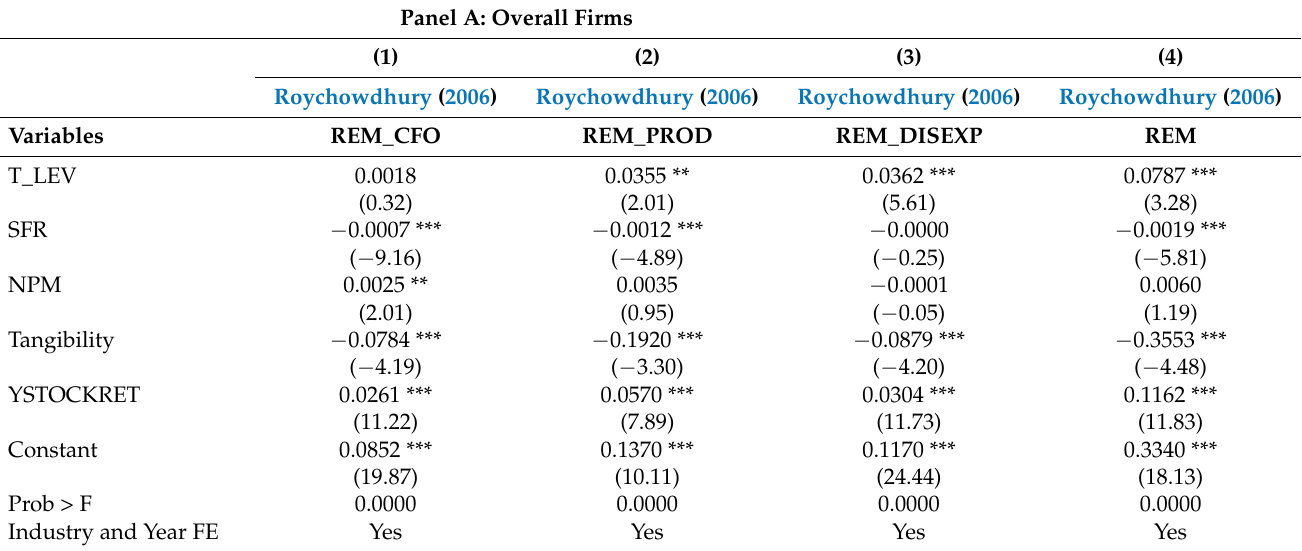
Table 3 present the outcomes of the impact of leverage (total debt/total assets) on REM practices in context of panel A (all Chinese non-financial listed firms). t-statistics are informed in parentheses. ***, **, and * indicates the p < 0.01, p < 0.05, and p < 0.1,